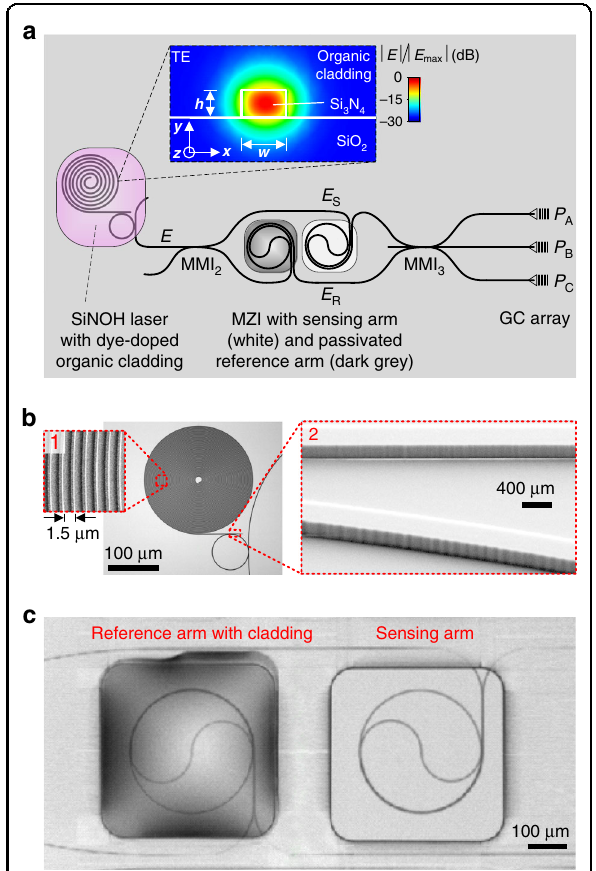
Fig. 2 Fabricated demonstrator chip, combining a SiNOH laser with an MZI-based biosensor. a The SiNOH laser cavity is an open- ended spiral WG that is evanescently coupled to a ring resonator, which feeds the input WG of the MZI-based sensor circuit. Resonant coupling of the counter-propagating modes in the ring leads to narrowband frequency-selective back-re fl ection from the outer end of the spiral. Broadband optical feedback from the inner end of the spiral is provided by re fl ection from the open WG end at the centre in combination with roughness-induced backscattering along the 20-mm-long spiral WG. The cladding window of the SiNOH laser (magenta) is fi lled with dye-doped PMMA acting as an organic gain material. The inset shows a typical cross- section (width w and height h ) of a SiNOH WG along with the the ! simulated electric fi eld magnitudes j E j of the fundamental quasi-TE mode. The sensor MZI is formed by a 2×2 MMI splitter (MMI 2 ) and a 3×3 MMI combiner (MMI 3 ), of which only two input ports are used. The splitter distributes the light originating from the SiNOH laser equally to the two spiral-shaped arms. The sensing arm (white) is exposed to the analyte solution, while the reference arm (dark grey) is passivated by a cover material. The three output signals of MMI 3 are coupled from the chip by a GC array and recorded by a camera (not shown). b Light- microscopy image of a SiNOH laser cavity without cladding. The spiral is densely coiled up with a 1.5-µm distance between neighbouring WGs, see Inset 1. The waveguides are subject to a certain sidewall roughness in the form of vertical grooves, see Inset 2. This roughness may lead to loss and to a resonantly enhanced coupling of the counter-propagating modes in the ring resonator. c Spiral-shaped WG in the MZI arms. For passivation purposes, the reference arm is covered with a low-index glue that is approximately index-matched to the aqueous analyte solution applied to the sensing